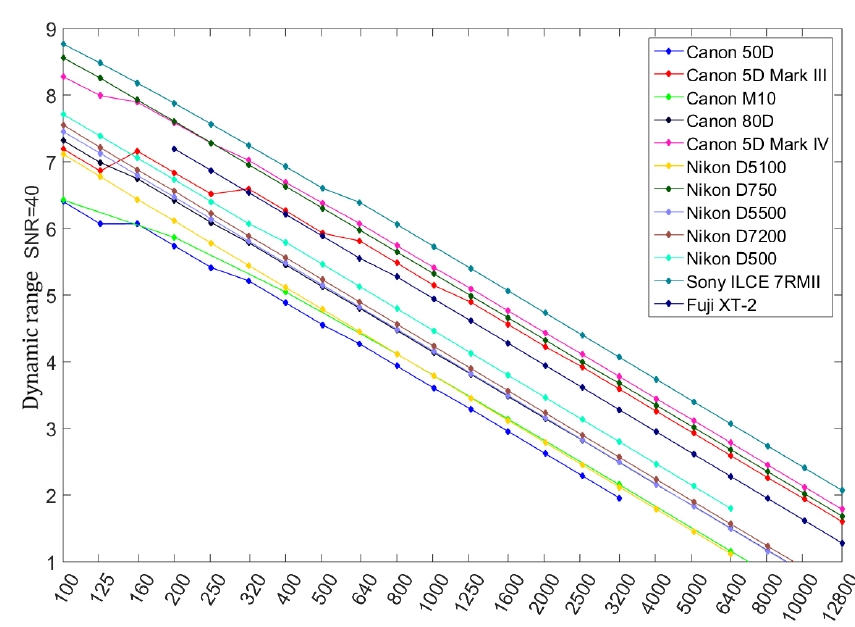
Figure 18. Photographic dynamic range for C = 20 µ m and SNR photo =